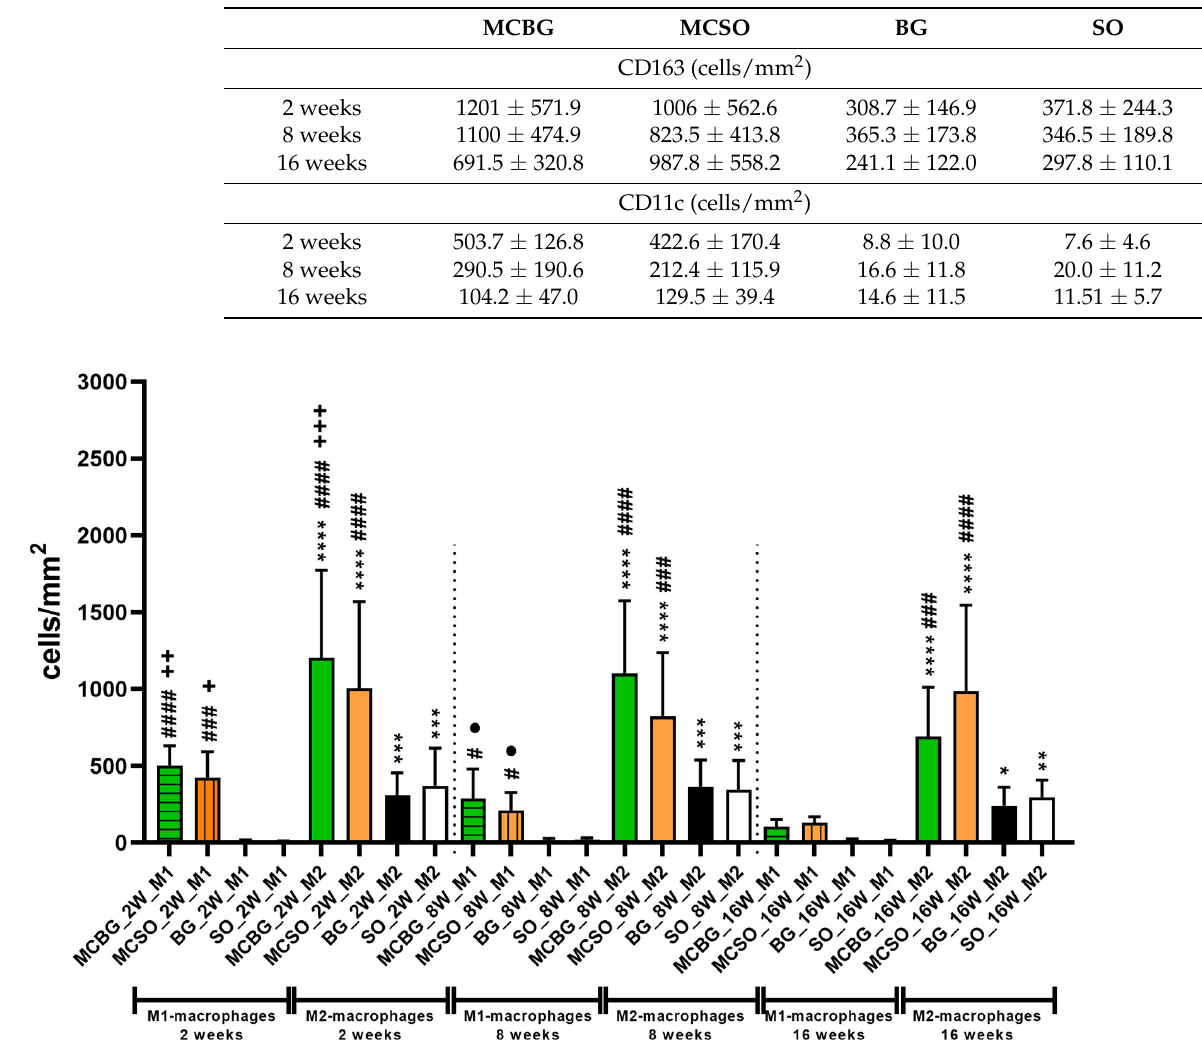
Figure 4. Results of the macrophage subtype measurements at 2, 8, and 16 weeks post implanta- tionem. Intraindividual signi fi cant di ff erences: * p < 0.05, ** p < 0.01, *** p < 0.001, and **** p < 0.0001. Interindividual signi fi cant di ff erences: # p < 0.05 ### p < 0.001, and #### p < 0.0001. + = signi fi cant di ff erences between 2- and 16-week datasets; = signi fi cant di ff erences between 8- and 16-week datasets. MCBG: membrane compartment above bone graft- fi lled defects; MCSO: membrane com- partment above sham operation; BG: bone graft- fi lled defect; and SO: sham operation bone defect.